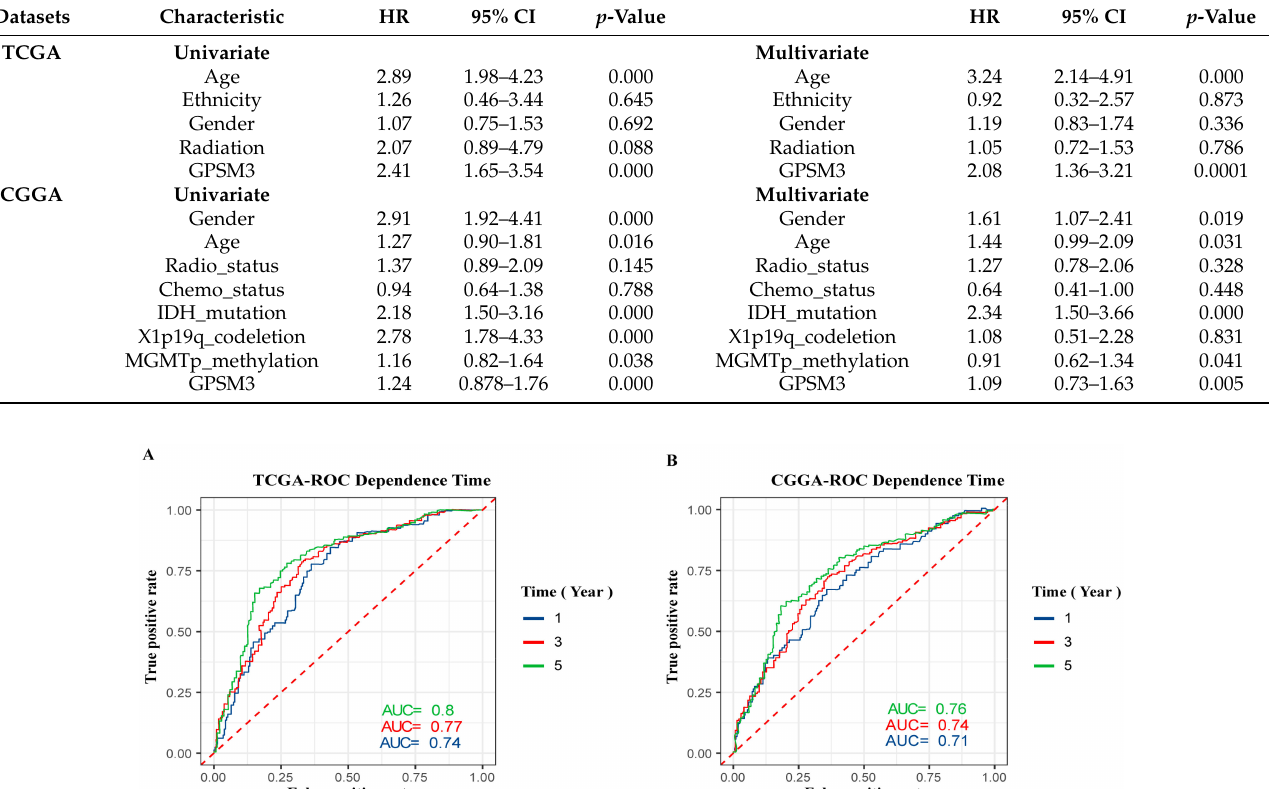
Table 1. Univariate and multivariate Cox analysis of clinic-pathologic characteristics in LGG based on CGGA and TCGA datasets.